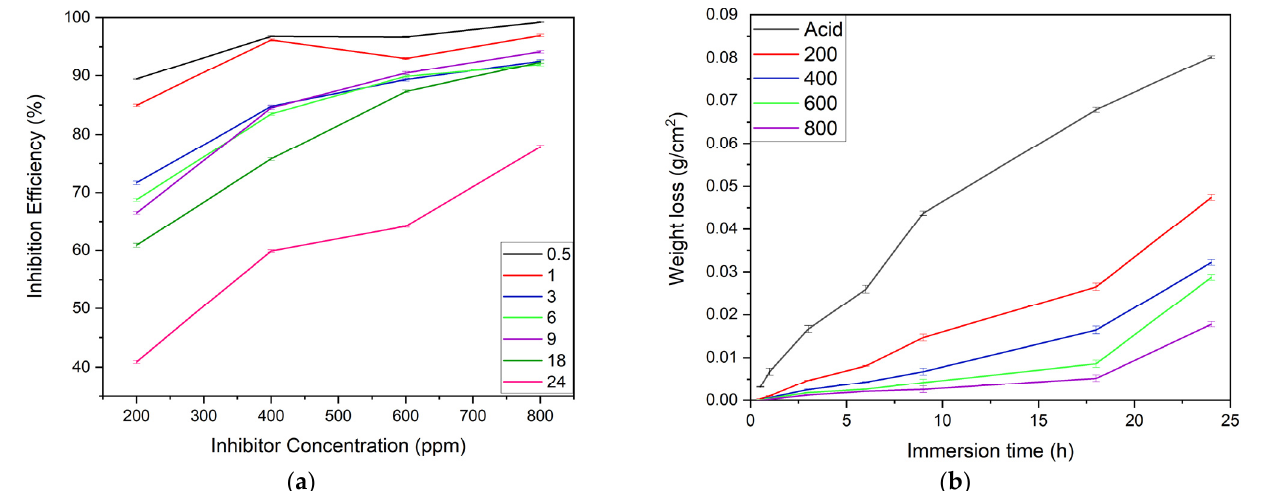
Figure 6. Effect of ( a ) concentrations of inhibitor on the I.E. for MS corrosion in 1 M H 2 SO 4 , and ( b ) immersion time on the weight loss of MS samples in acid and different inhibitor solutions ( n = 3 for each